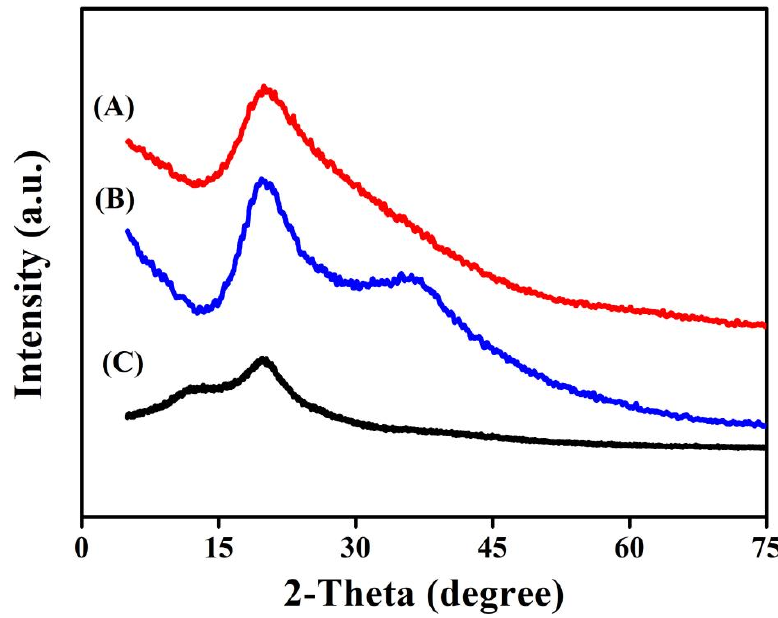
Figure 3. X-ray diffraction (XRD) patterns of ( A ) CS-TA, ( B ) CS-TA-Na, ( C ) chitosan.